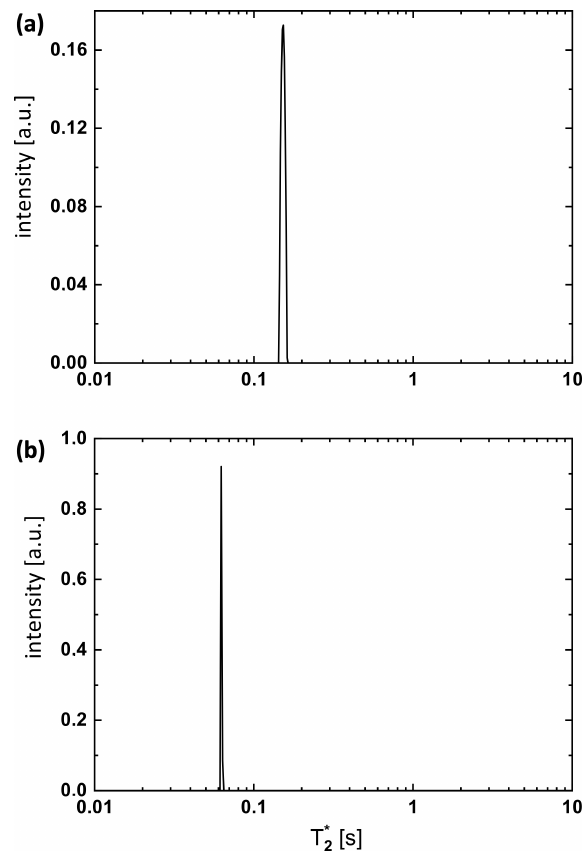
cused by the second gradient G 2 .